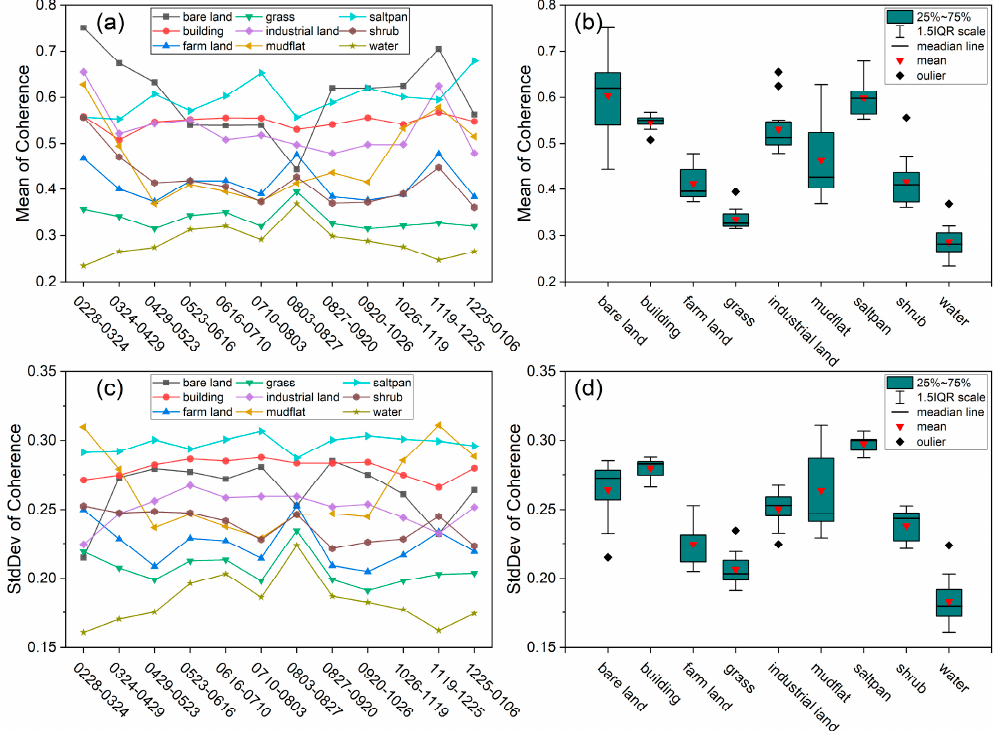
Figure 15. Monthly mean and standard deviation of coherence on nine land cover types in 2019. ( a ) Temporal change of coherence mean for different land cover; ( b ) Statistics of coherence mean for different land cover; ( c ) Temporal change of coherence standard deviation for different land cover; ( d ) Statistics of coherence standard deviation for different land cover.